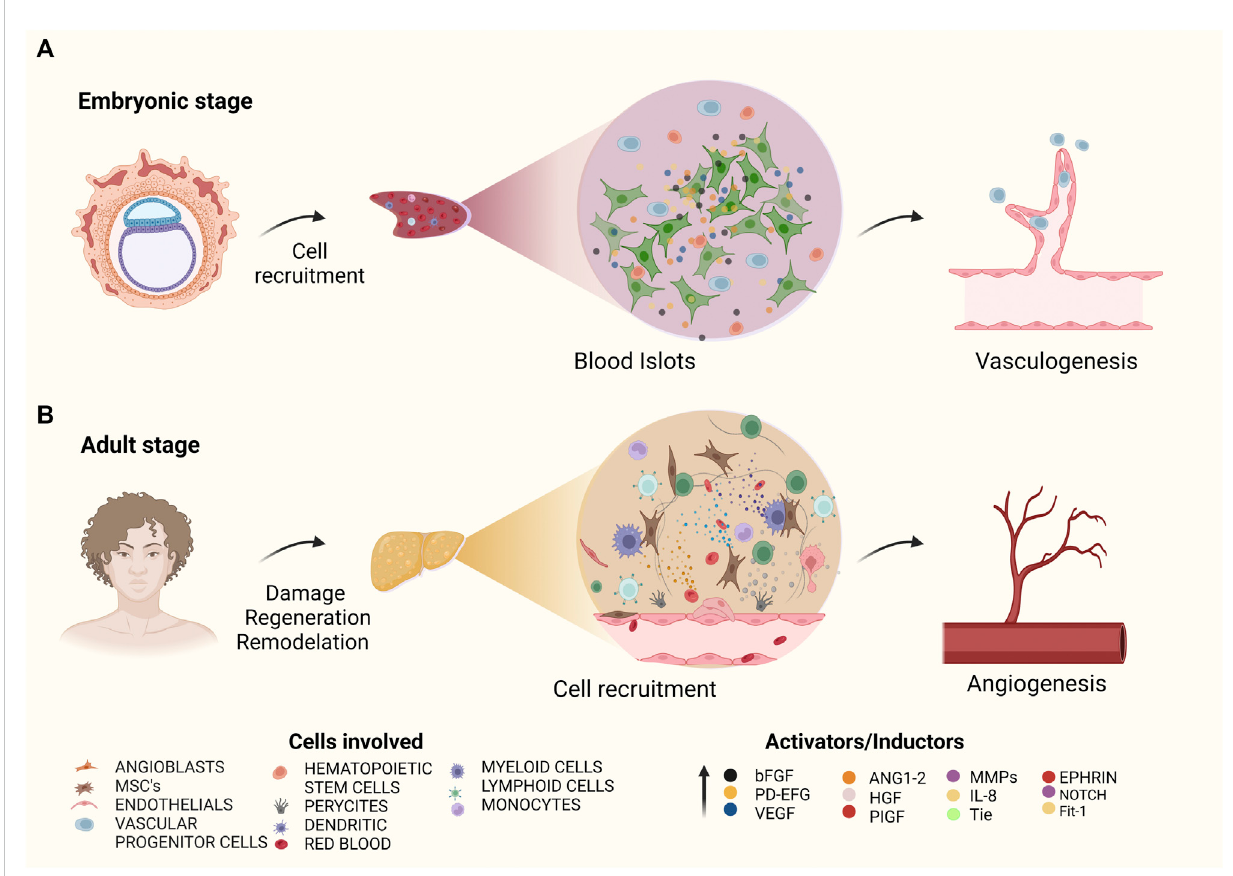
FIGURE 1 The formation and remodeling of blood vessels begin at the angiogenesis stage in the embryonic process (A) . Vasculogenesis begins in pregnant stages from blood islets, where vascular progenitor cells will differentiate into angioblasts, while in adult stages vascular progenitor cells will differentiate into pericytes supporting the physiological process of angiogenesis to form or renew blood vessels are formed or renewed from pre-existing vessels (B) , Schematic illustration of the key growth factors and proteins and cells that stimulate these processes vasculogenesis and